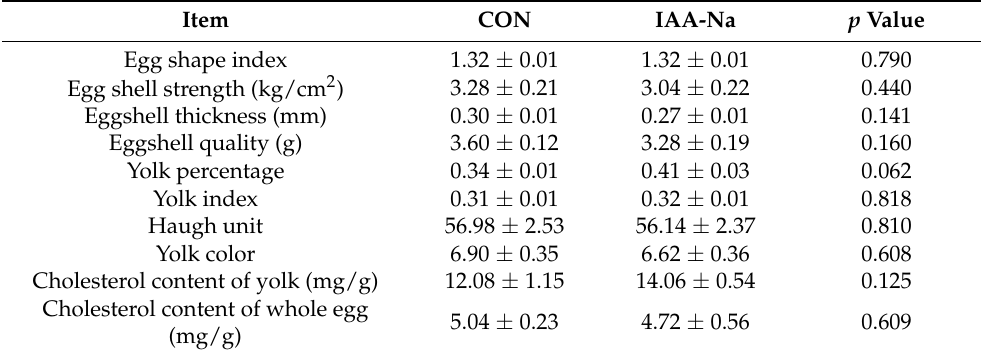
Table 3. Effect of dietary IAA-Na supplementation on the egg quality in Danzhou